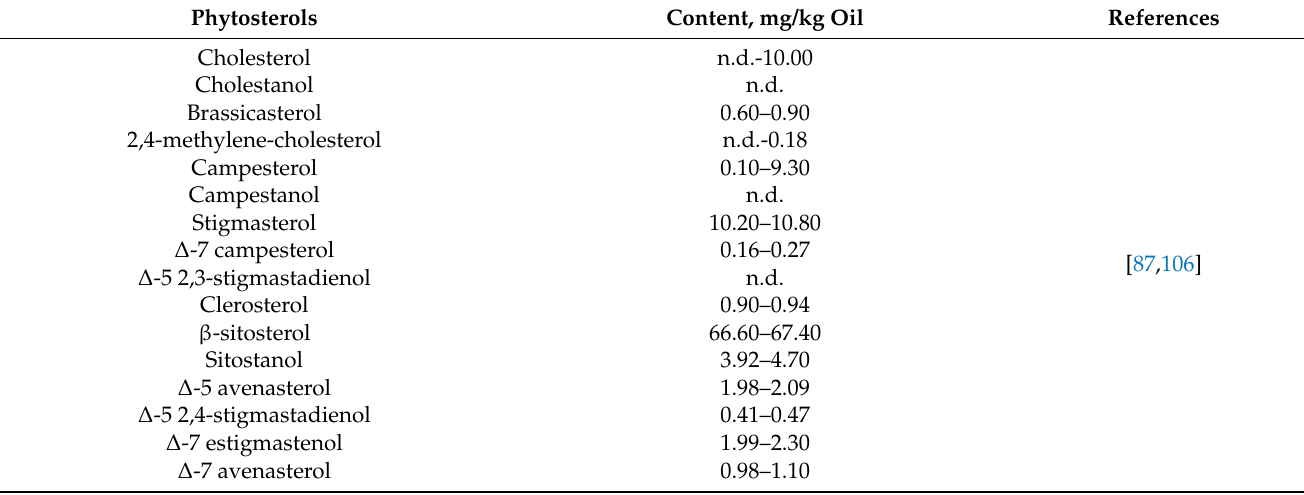
Table 3. Main phytosterols in grape seed oil ( Vitis vinifera